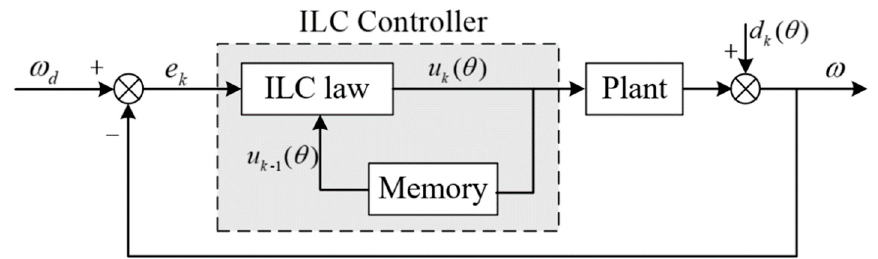
Figure 1. Block diagram of iterative learning controller (ILC).